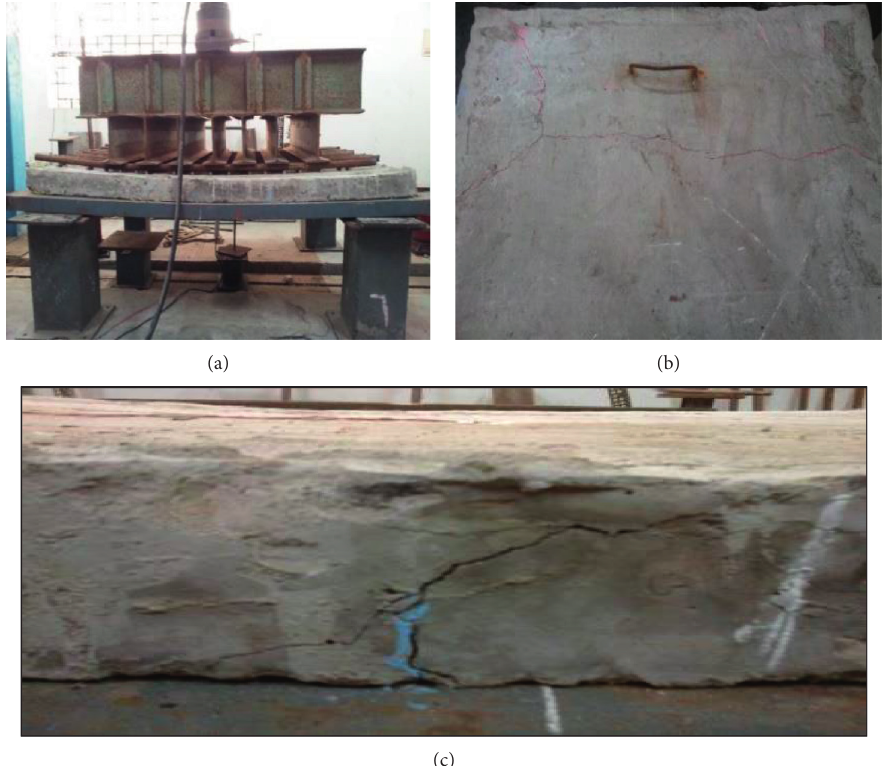
Figure 12: Failure pattern of the conventional slab. (a) Deflected configuration. (b) Crack propagation along the width. (c) Crack extension through the depth of the